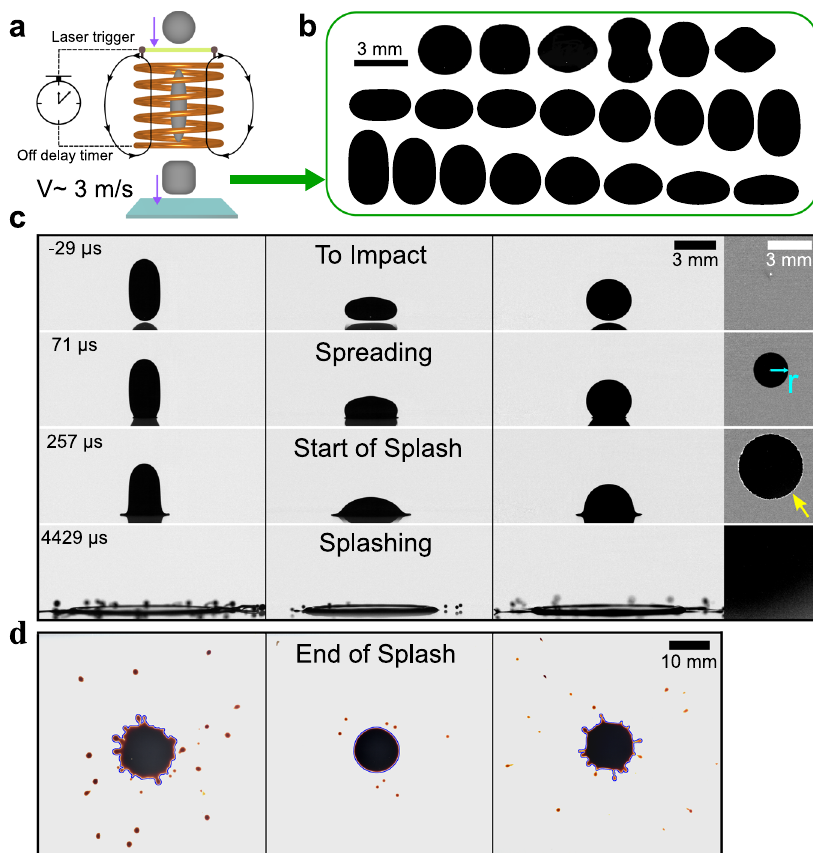
Fig. 1 Experimental setup and typical impact events by different shaped drops. a A schematics of our setup (not in scale). A free-falling ferro fl uid drop fi rst passes through a magnetic coil, which stretches the drop into a long spindle-like shape. The magnetic fi eld is then turned off and the falling drop starts to oscillate across many different shapes due to surface tension. The timing of turning off the magnetic fi eld is precisely controlled by a laser trigger and an off-delay timer. By fi ne-tuning the turn-off time of magnetic fi eld, we realize different drop shapes at the impact moment. b Examples of drop cross- sectional shapes, in 3D they are axisymmetric around the vertical central axis. c Side-view snapshots of impact events by three typical shapes: elongated (column 1), fl attened (column 2), and spherical (column 3) drops. They have the same impact velocity, V = 2.9 ± 0.2 m/s. Column 4 shows the bottom view of column 3. The cyan arrow indicates the radial position of contact line, r . The yellow arrow indicates the bright interference pattern due to the liquid sheet fl ying off the substrate, whose fi rst appearance indicates the onset of splash. d Corresponding splatter patterns of the three drops in ( c ), which indicate the amount of splash. The blue curve shows the border between the parent drop and the satellite three categories: n = 2 is de fi ned as “ round ” for its similarity to a sphere, n > 2 is de fi ned as “ fl at ” due to its more fl attened bottom than a sphere, and n < 2 is de fi ned as “ sharp ” because of its more sharpened bottom than a sphere. The schematics in Fig. 2b